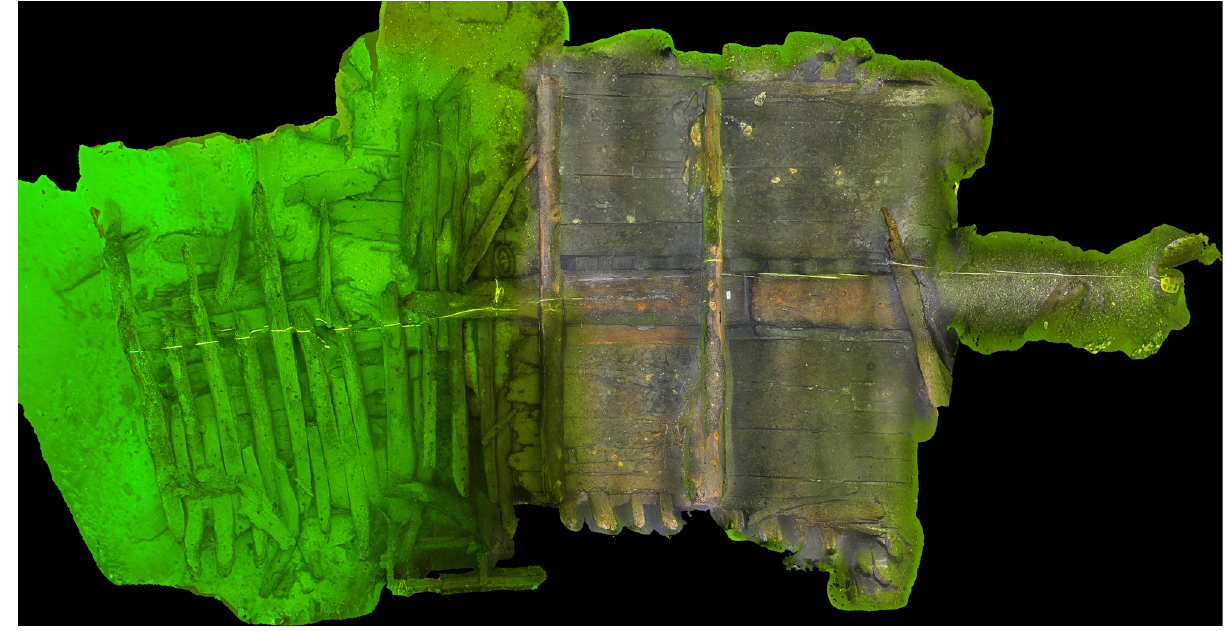
Figure 2. Digital elevation model of the Straatvaarder wreck, visualised in QuantumGIS